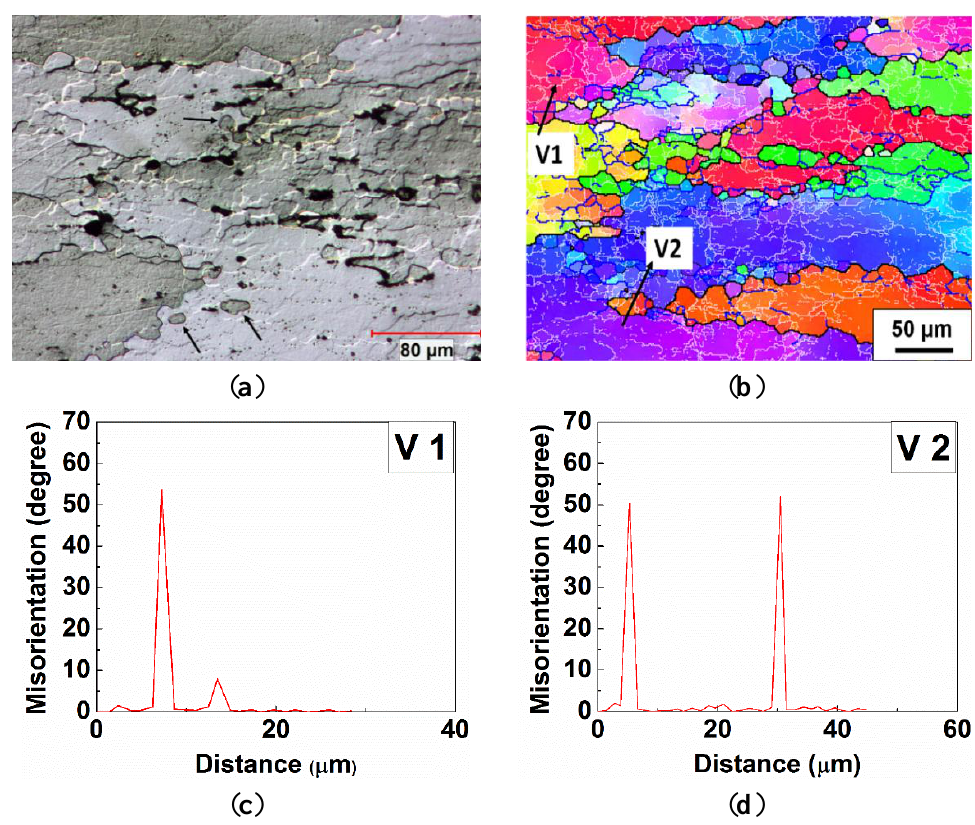
Figure 7. Deformed microstructures under deformation condition at 450 °C, 0.01 s −1 : ( a ) optical micrograph; ( b ) orientation imaging map; ( c ) a misorientation profile along vector V1; and ( d ) a misorientation profile along vector